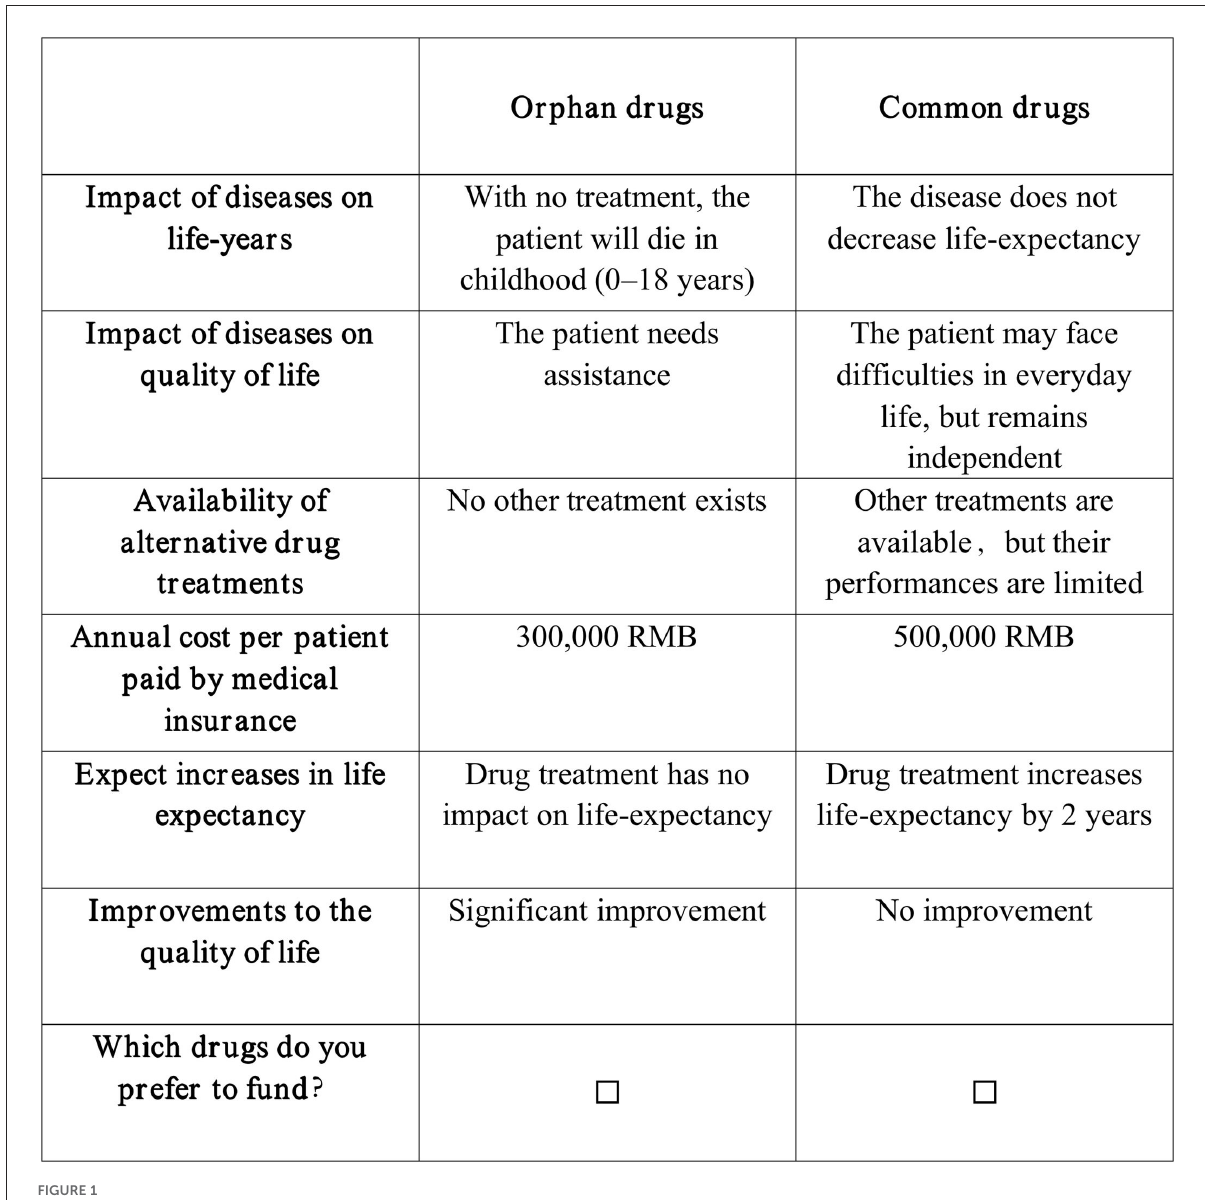
FIGURE1 Example of choice